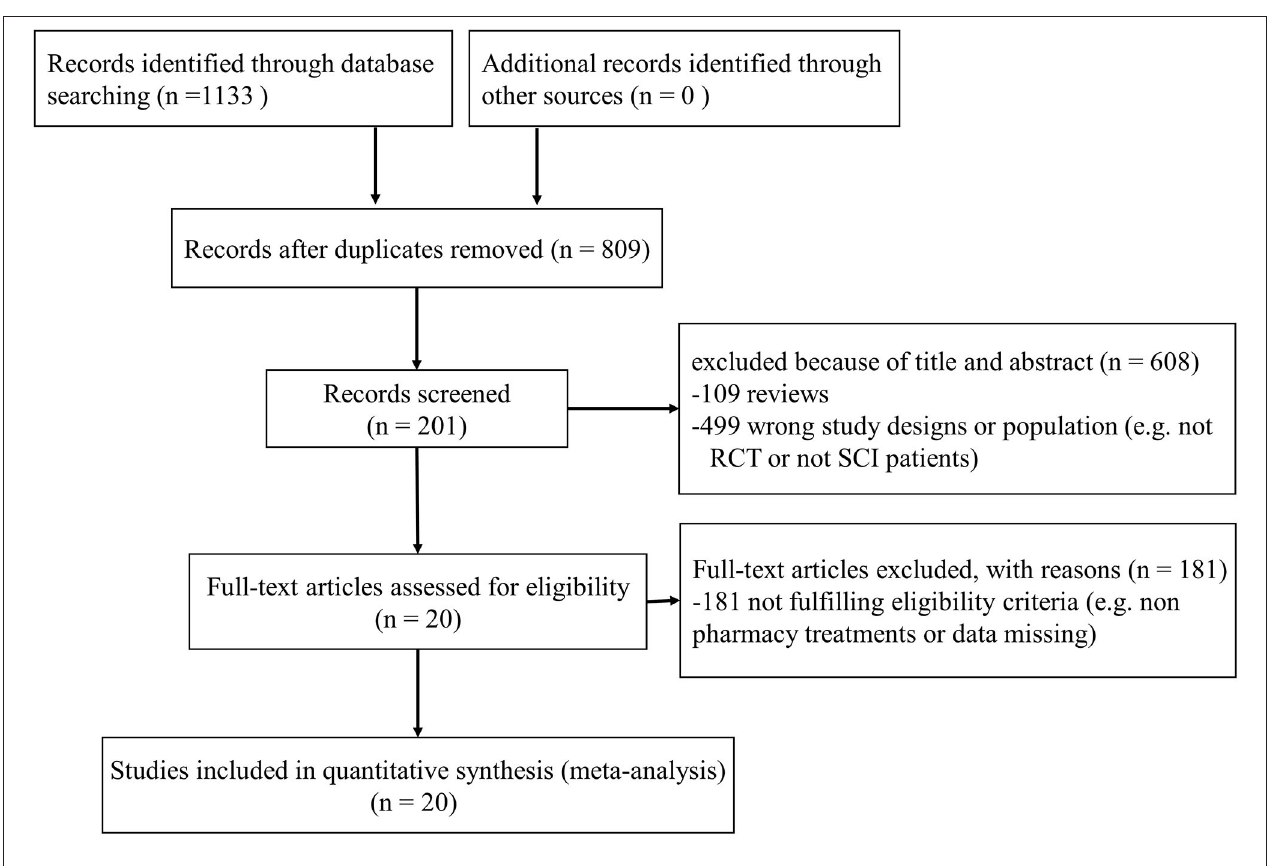
FIGURE 1 | A study selection